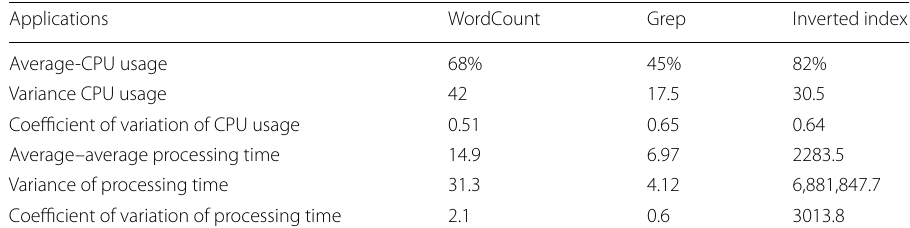
Table 1 CPU utilization in three applications